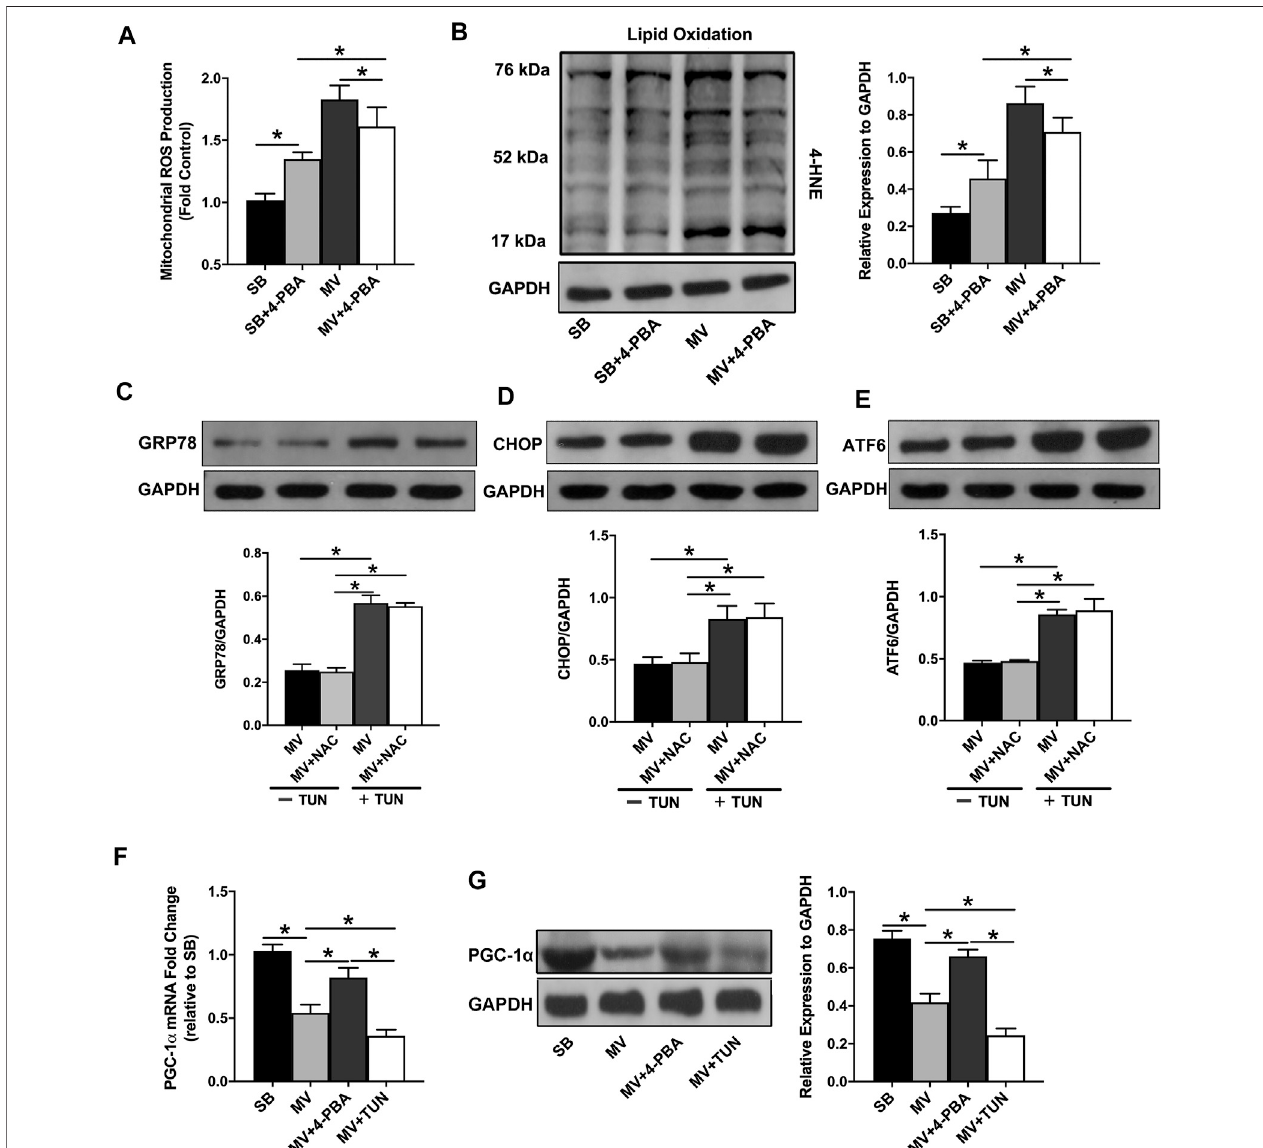
FIGURE 5 | Relationship between ER stress and oxidative stress in the diaphragm during MV. Mitochondrial ROS production (A) and lipid oxidation (B) were measuredattheendofMV.InhibitionofERstressby4-PBAdecreasedoxidativestressinthediaphragmduringMV.Theproteinexpression levelsofGRP78 (C) ,CHOP (D) and ATF6 (E) were measured by immunoblottingto evaluate ER stress levels. Administration ofNAC failed to alter ER stress levels in the diaphragm during MVin the absenceandpresenceoftheERstressinducerTUN.RT-PCR (F) andwesternblots (G) revealedthatPGC-1 α mRNAandproteinexpressionsweredownregulated byMVinrats.TheinhibitionofERstresswith4-PBAupregulatedPGC-1 α expressioninthediaphragm,whereastheinductionofERstresswithTUNfurtherlydecreased its expression in the diaphragm. * p < 0.001 (ANOVA followed by the Tukey HSD test, n = 6 per group). ROS = reactive oxygen species, NAC = N-acetylcysteine, MV = mechanical ventilation, 4-PBA = 4-phenylbutyrate, TUN = tunicamycin, 4-HNE = 4-hydroxynonenal.